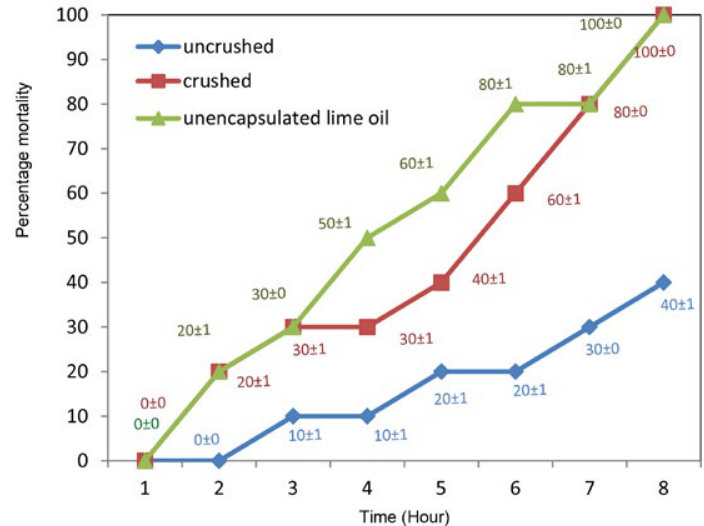
Figure 7. Percentage mortality of shrimp nauplii against time for different lime oil